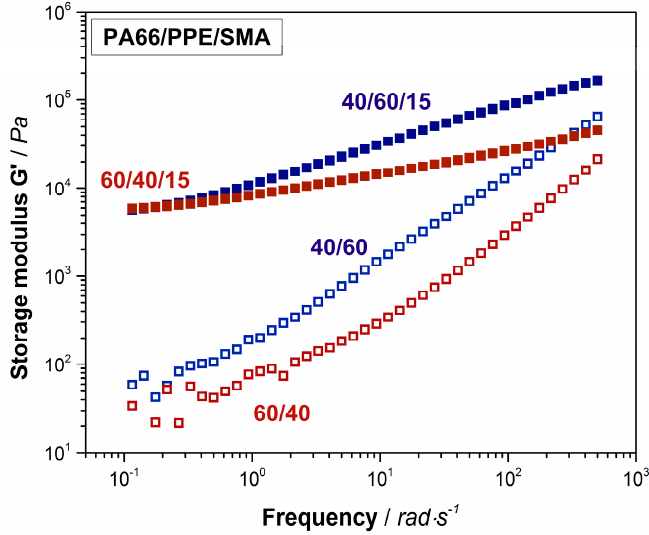
Figure A3. Shear rheological results of 60 / 40 (red hollow rectangular) and 40 / 60 (blue hollow rectangular) neat blends and their equivalents with 15 wt% SMA (red and blue rectangular).